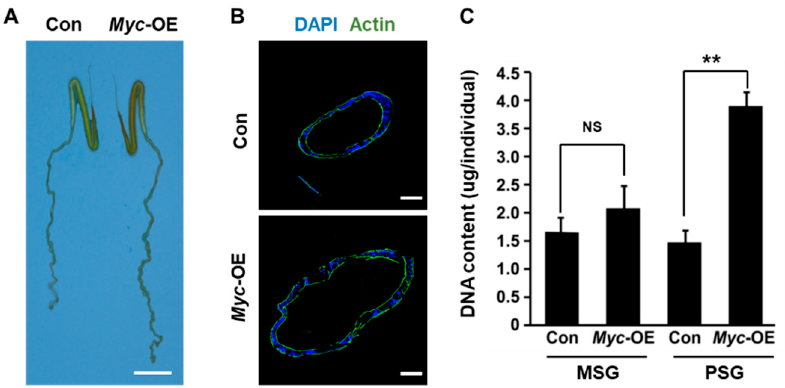
Figure 3. PSG-specific Myc overexpression increases DNA content. ( A ) Myc overexpression resulted in an increase in PSG size. ( B ) Immunofluorescence analysis of the nuclei size with DAPI staining. ( C ) Total DNA content in the PSG, not in the MSG, was highly increased following PSG-specific Myc overexpression. Values are represented as means ± S.E. (error bars). For the significance test: ** p < 0.01 vs. the control.